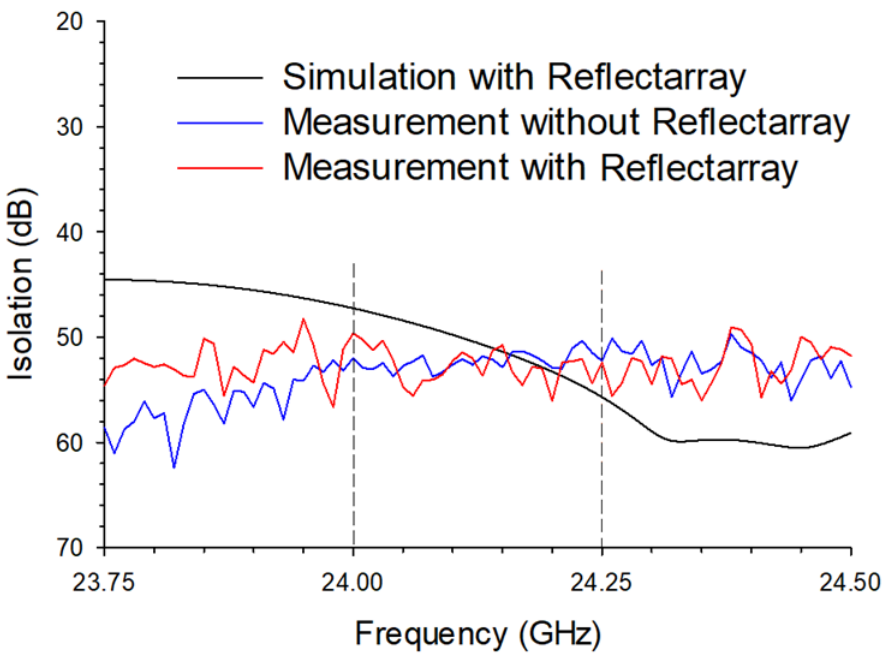
Figure 8. The measured isolations between the transmitting antenna and the receiving antenna without and with the reflectarray antenna. All four isolations were averaged.